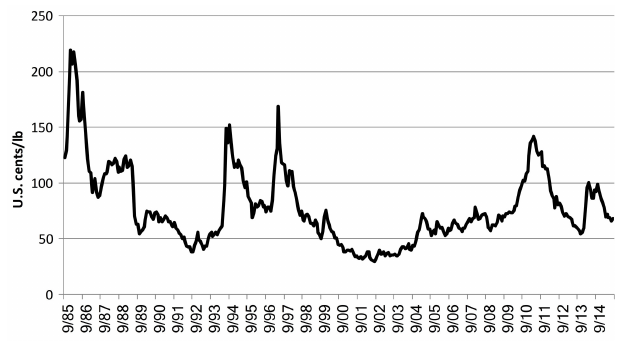
Fig. 5 . International price of mild Arabica coffee: New York Stock Exchange, Monthly average (US cents/lb 1985–2015) in real terms (CPI 1982–1984 = 100). Source: International Coffee Organization (ICO) for coffee prices, and U.S. Department of Labor, Bureau of Labor Statistics for the Consumer Price Index